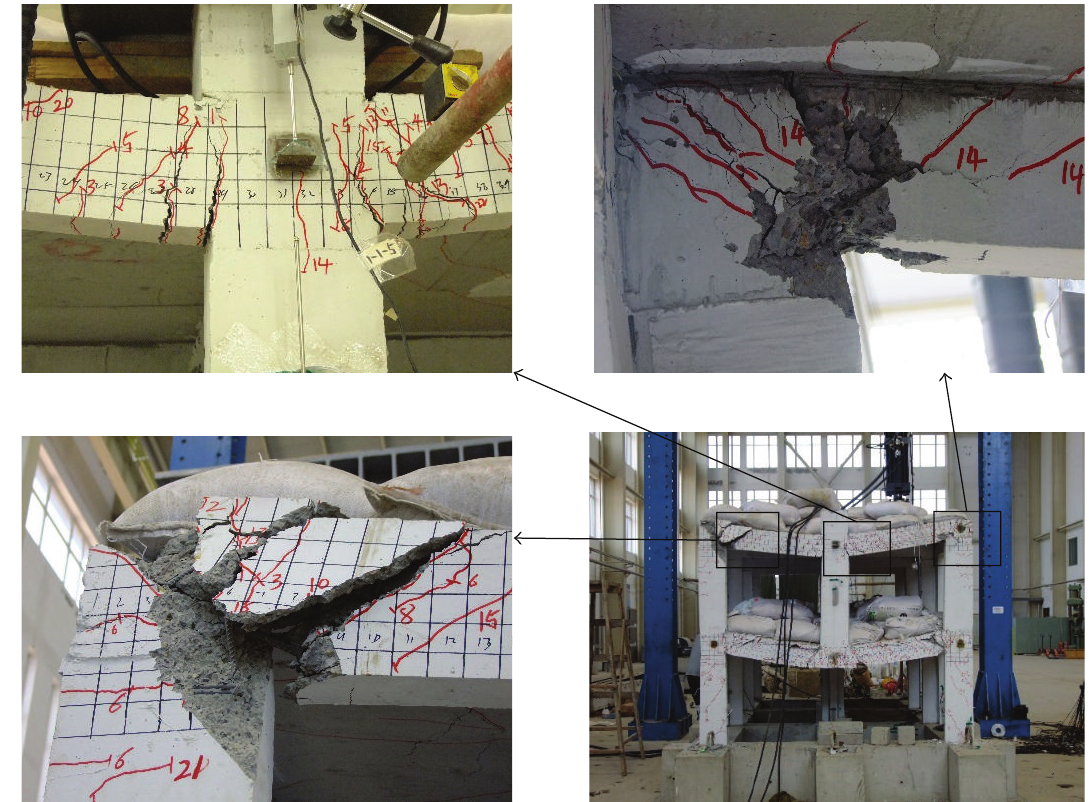
Figure 7: Failure modes of the test model.